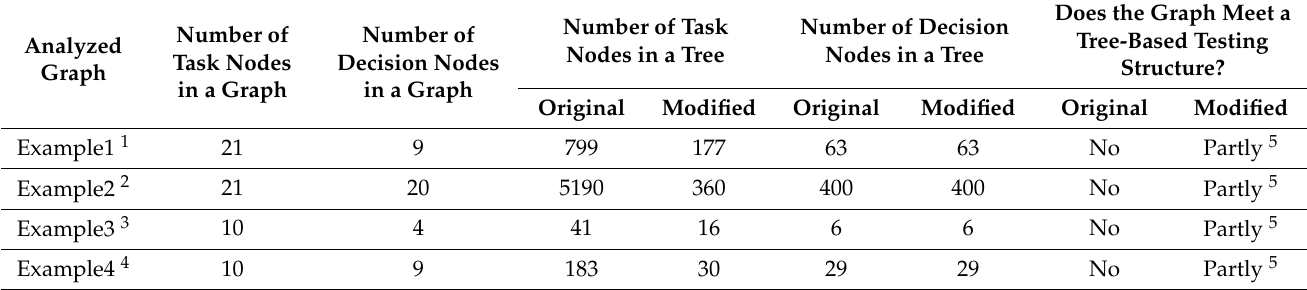
Table 2. Contextual graph transformation to Practice tree result